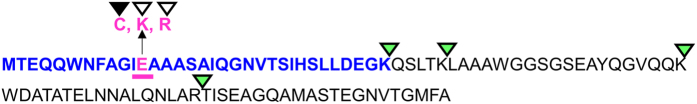
Molecular engineering of the EsxA protein to facilitate proteomic analysis.The amino acid sequence of EsxA from M. tuberculosis. Blue bolded residues indicate the natural N-terminal fragment generated by digestion with trypsin. Green triangles indicate other endogenous trypsin cleavage sites. The magenta underlined residue (E12) was changed to K or R, which introduces a novel site of trypsin cleavage (open triangle) or C residue which upon aminoethylation is a substrate for trypsin (closed triangle).